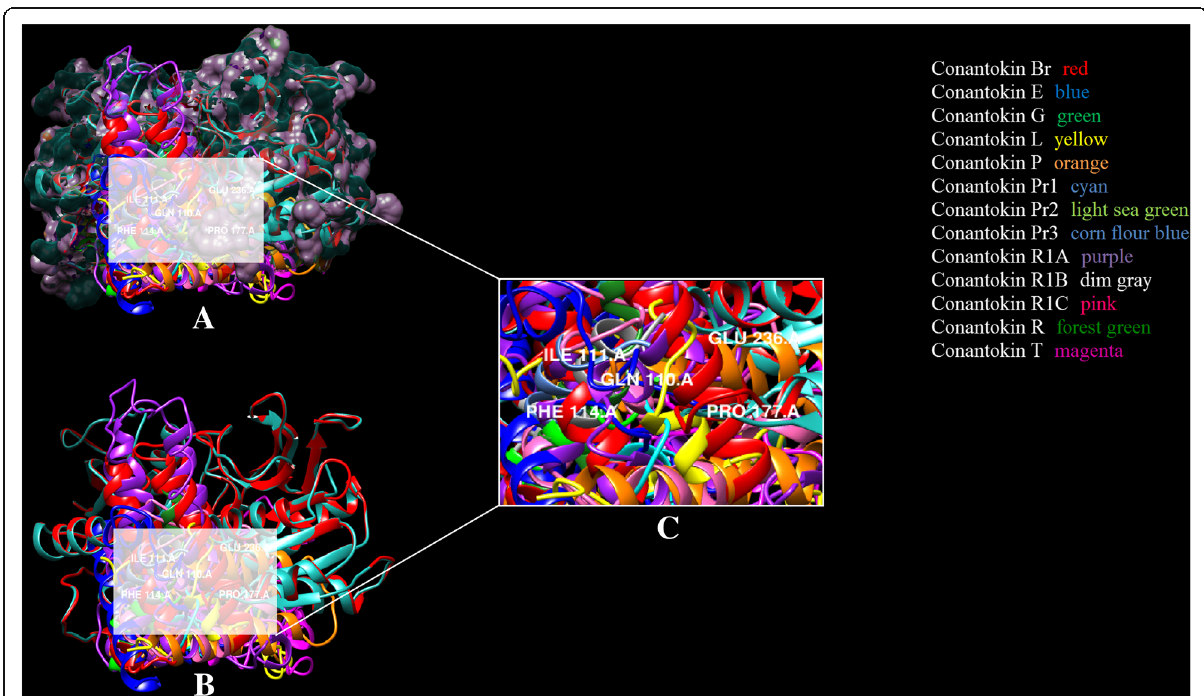
Fig. 5 a Conantokins in complex with the NMDAR (humans). b Active residues in the binding pocket highlighted (white) of the NMDAR with conantokin ligands. c Binding pocket highlighted and focused. Three-dimensional binding representation of all toxins from the ligand dataset: conantokin Br (red), conantokin E (blue), conantokin G (green), conantokin L (yellow), conantokin P (orange), conantokin Pr1 (cyan), conantokin Pr2 (light sea green), conantokin Pr3 (cornflour blue), conantokin R1A (purple), conantokin R1B (dim gray), conantokin R1C (pink), conantokin R (forest green), conantokin T (magenta) with the NMDA receptor in